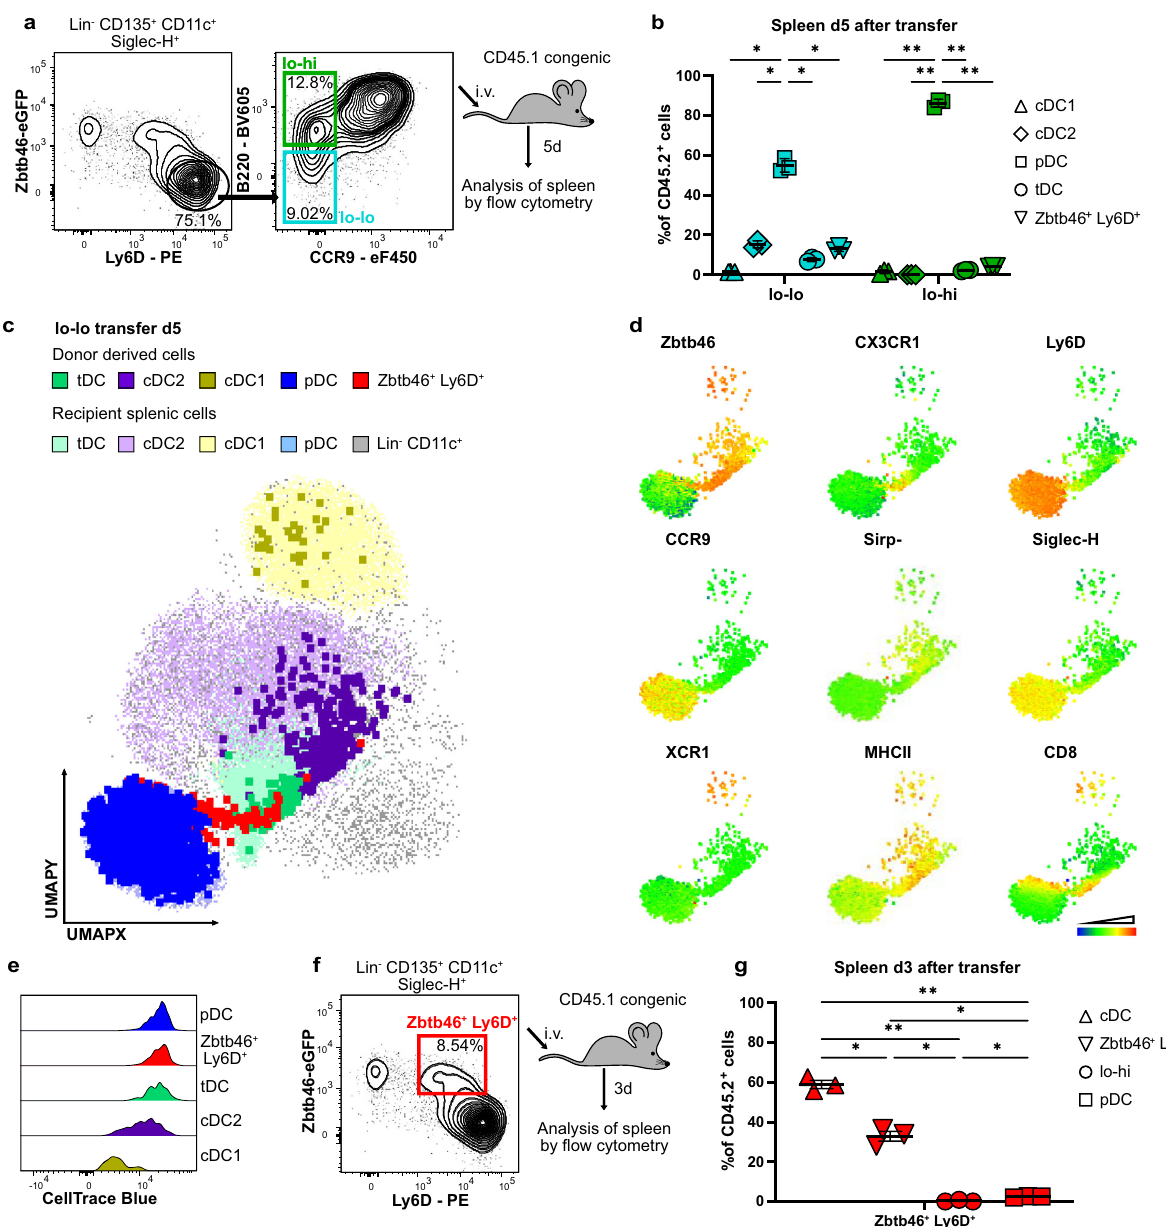
Fig. 5 Cell fate of Siglec-H + Ly6D hi Zbtb46 – CCR9 lo B220 lo and CCR9 lo B220 hi precursors after transfer in vivo. a Siglec-H + Ly6D hi Zbtb46 – lo-lo and lo-hi cells were sorted from BM of heterozygous Zbtb46 gfp mice and transferred i.v. into congenic CD45.1 mice. After 5 days splenocytes were analyzed by multiparameter spectral fl ow cytometry. b Phenotype of recovered donor derived cells on day 5 after injection depicted as percentage of total CD45.2 + recovered cells ( n = 3, mean ± SEM). c From each recipient of lo-lo precursors 400,000 Lin – CD11c + recipient cells and all donor-derived cells were concatenated and UMAP dimensionality reduction was performed. DC subsets were manually gated for both recipient and donor-derived cells and projected onto the UMAP. Donor-derived cells are highlighted as large dots. d Log 2 normalized surface marker and Zbtb46 expression in donor-derived cells overlaid onto the UMAP of ( c ) using a color scale from blue (low expression) to red (high expression). e Histograms showing fl uorescence intensity of CellTrace Blue dye (normalized to mode) in cells derived from transferred lo-lo precursors after 5 days. f Siglec-H + Zbtb46 + Ly6D + cells were sorted from BM of heterozygous Zbtb46 gfp mice and transferred i.v. into congenic CD45.1 mice. After 3 days splenocytes were analyzed by multiparameter spectral fl ow cytometry. g Phenotype of recovered donor derived cells on day 3 after injection depicted as percentage of total recovered cells ( n = 3, mean ±